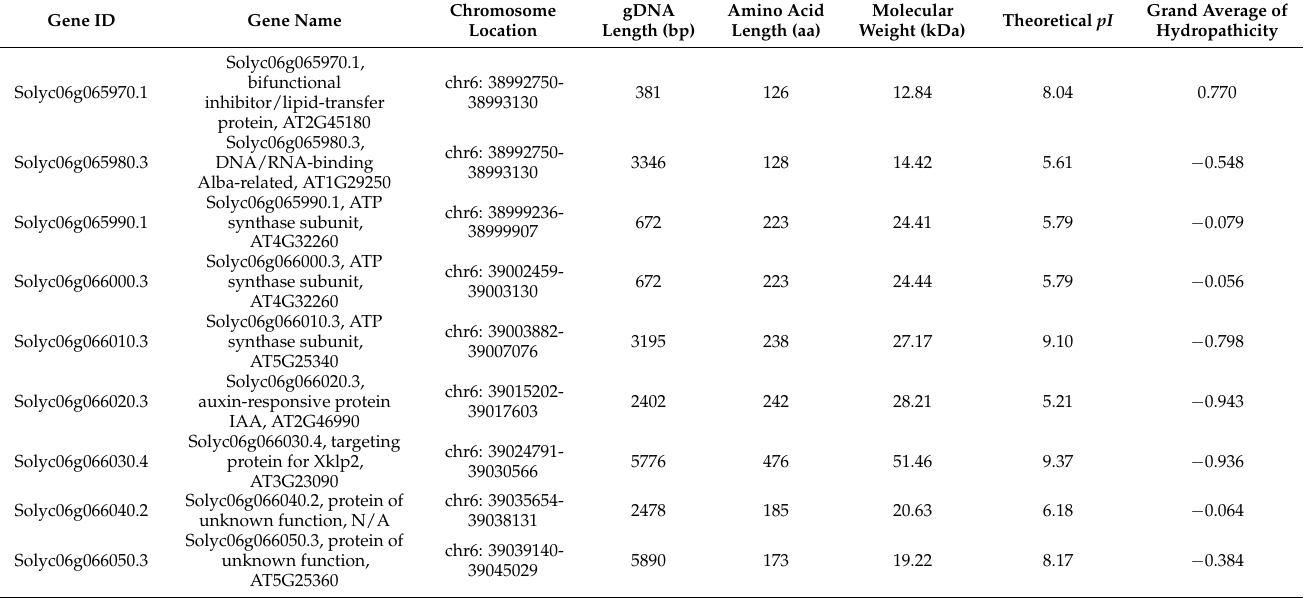
Table 2. Analysis of properties of the genes and encoding amino acid sequences within 50 kb upstream and downstream of TGS0892 in